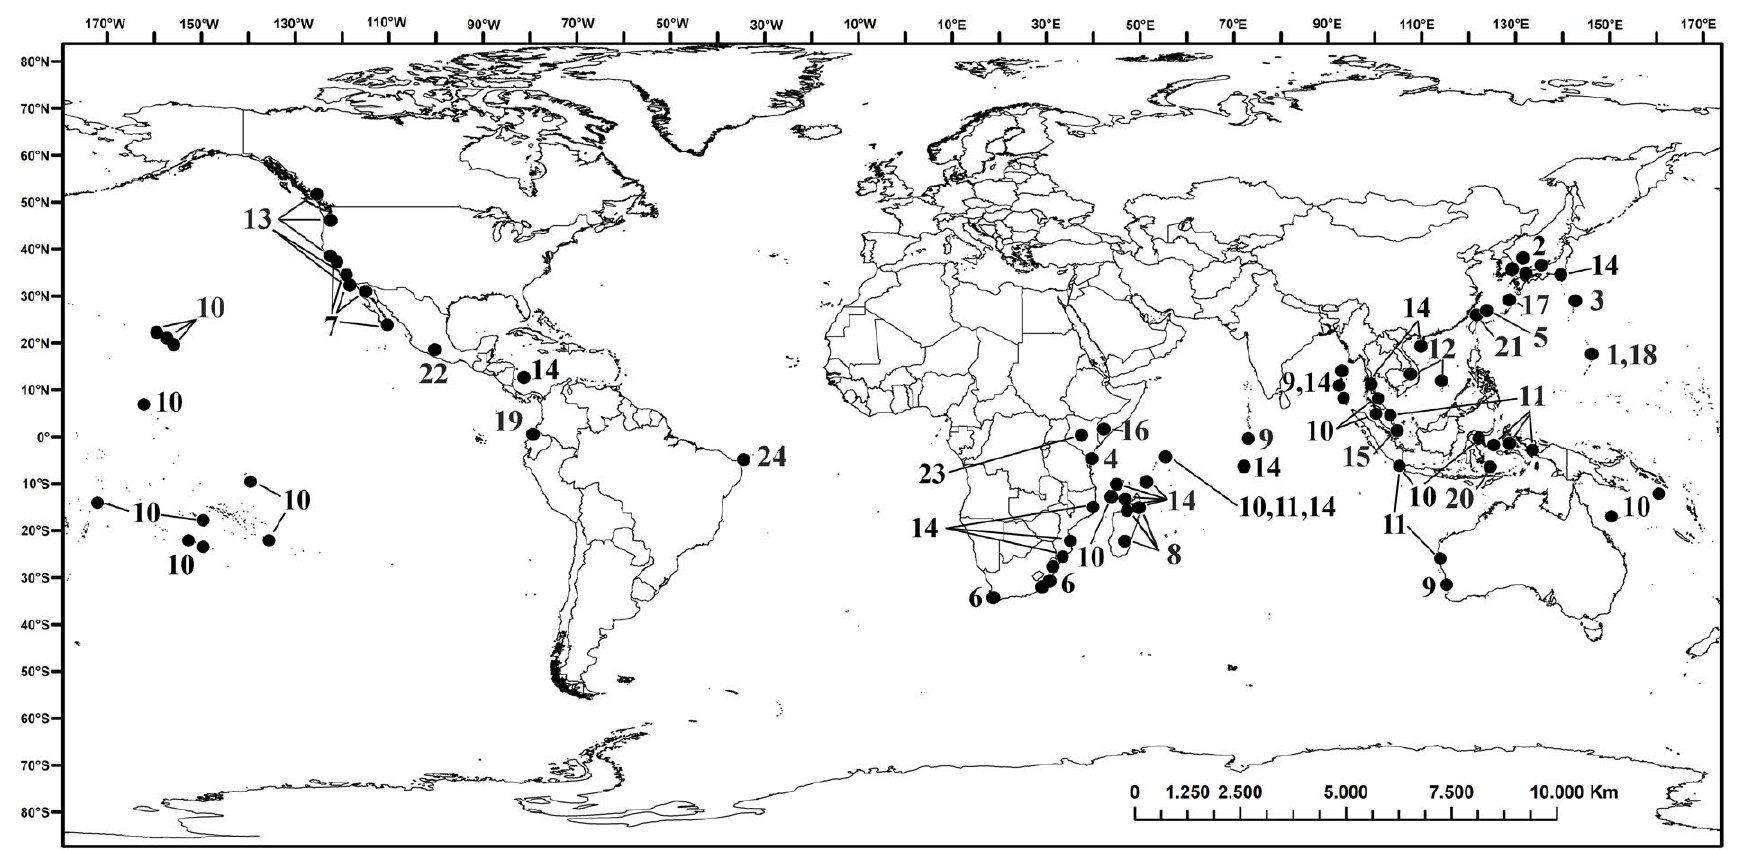
Figure 4. Distribution map of Alloniscus Dana, 1854: 1, A. allspachi Nunomura, 2001; 2, A. balssi (Verhoeff, 1928); 3, A. boninensis Nunomura, 1984; 4, A. gerardi Arcangeli, 1960; 5, A. maculatus Nunomura, 1984; 6, A. marinus Collinge, 1920; 7, A. mirabilis (Stuxberg, 1875); 8, A. nacreus Collinge, 1922; 9, A. nicobaricus Budde-Lund, 1885; 10, A. oahuensis Budde-Lund, 1885; 11, A. pallidulus Budde-Lund, 1885; 12, A. pardii Arcangeli, 1960; 13, A. perconvexus Dana, 1856; 14, A. pigmentatus Budde-Lund, 1885; 15, A. priolensis Arcangeli, 1960; 16, A. robustus Ferrara, 1974; 17, A. ryukyuensis Nunomura, 1984; 18, A. saipanensis Nunomura, 2001; 19, A. salinarum Vandel, 1968; 20, A. schaedleri Arcangeli, 1960; 21, A. silvestrii Arcangeli, 1960; 22, A. thalassophilus Rioja, 1964; 23, “ Alloniscus ” simplex Schmölzer, 1974; and 24, Alloniscus buckupi Campos-Filho & Cardoso n.